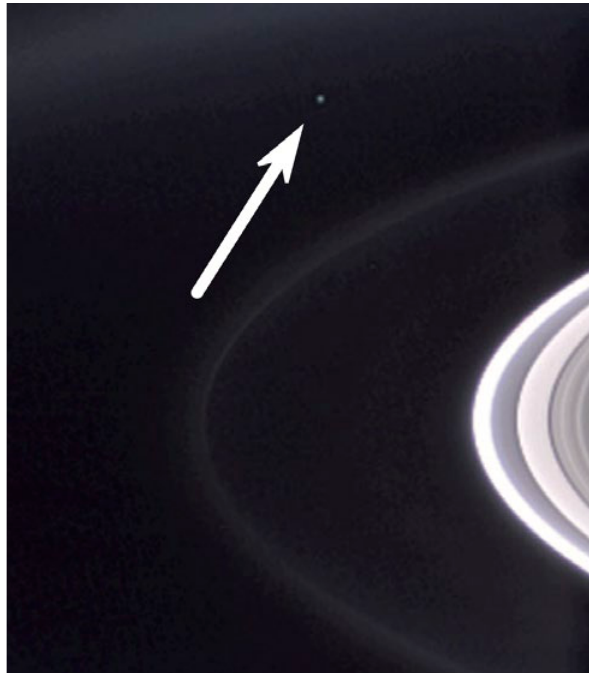
Figure 1. Photograph taken by the Cassini Orbiter spacecraft on September 15, 2006, at a distance of 1.5 billion kilometers from Earth. The dot to the upper left of Saturn’s rings, indicated by the arrow, is the Earth. Saturn was used to block the direct light from the Sun otherwise the Earth could not have been